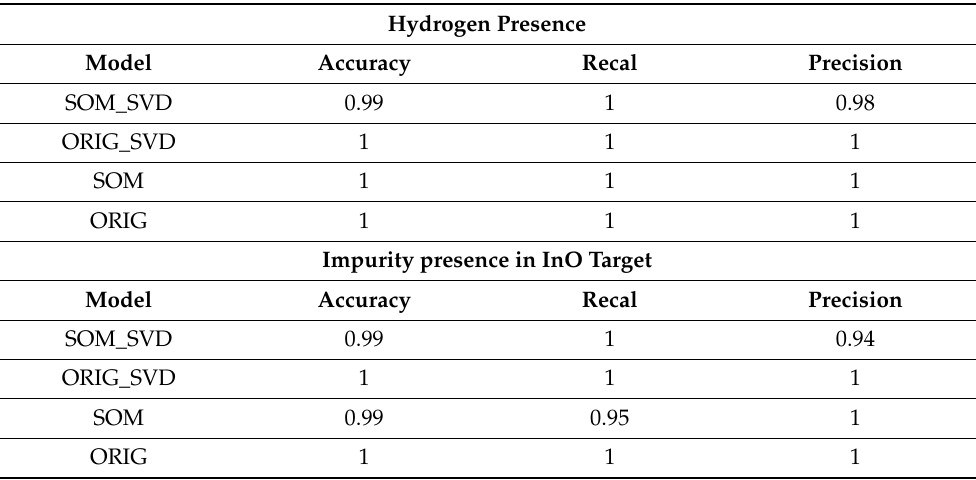
Table 1. Confusion matrix of model classification associated with Hydrogen presence and impurity in the indium oxide